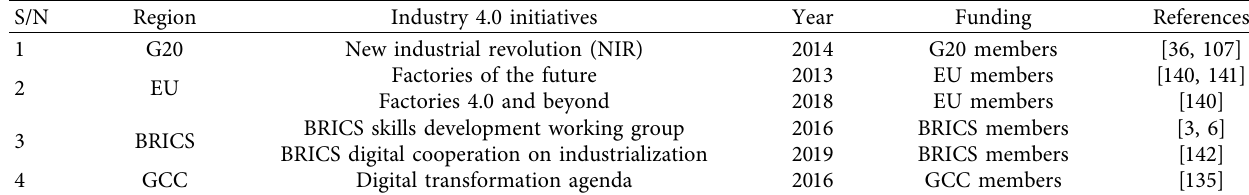
Table 6: Industry 4.0 initiatives for regional and international cooperation.